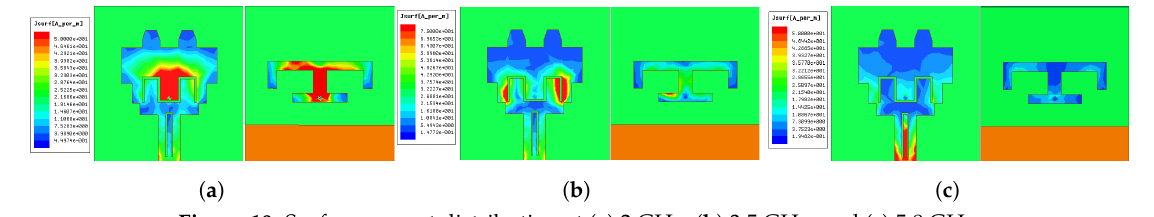
Figure 10. Surface current distribution at ( a ) 2 GHz, ( b ) 3.5 GHz, and ( c ) 5.8 GHz.